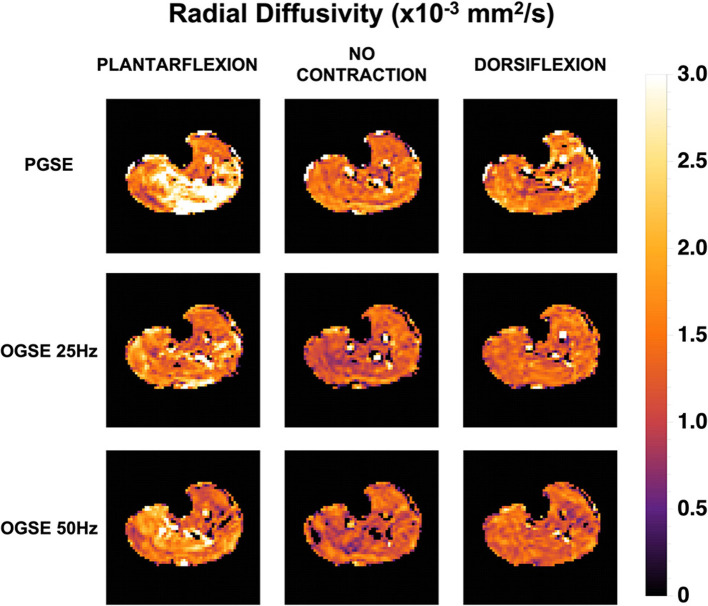
Radial diffusivity (RD) maps for one female volunteer. Abnormally elevated diffusion values are observed in the posterior compartment of the lower leg during plantarflexion and in the anterior compartment during dorsiflexion when using a pulsed gradient spin echo (PGSE) sequence.